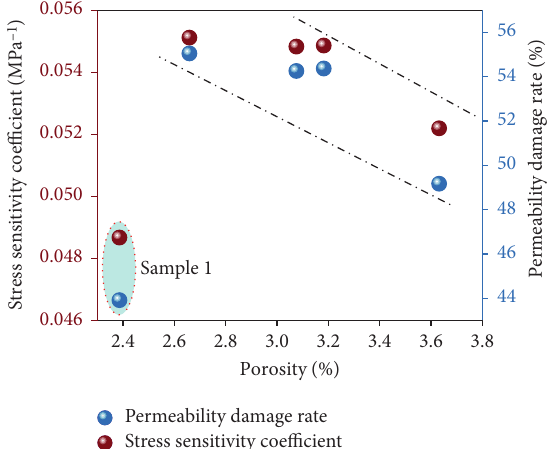
Figure 11: Porosity versus stress sensitivity coefficient and per- meability damage rate of shale at initial effective